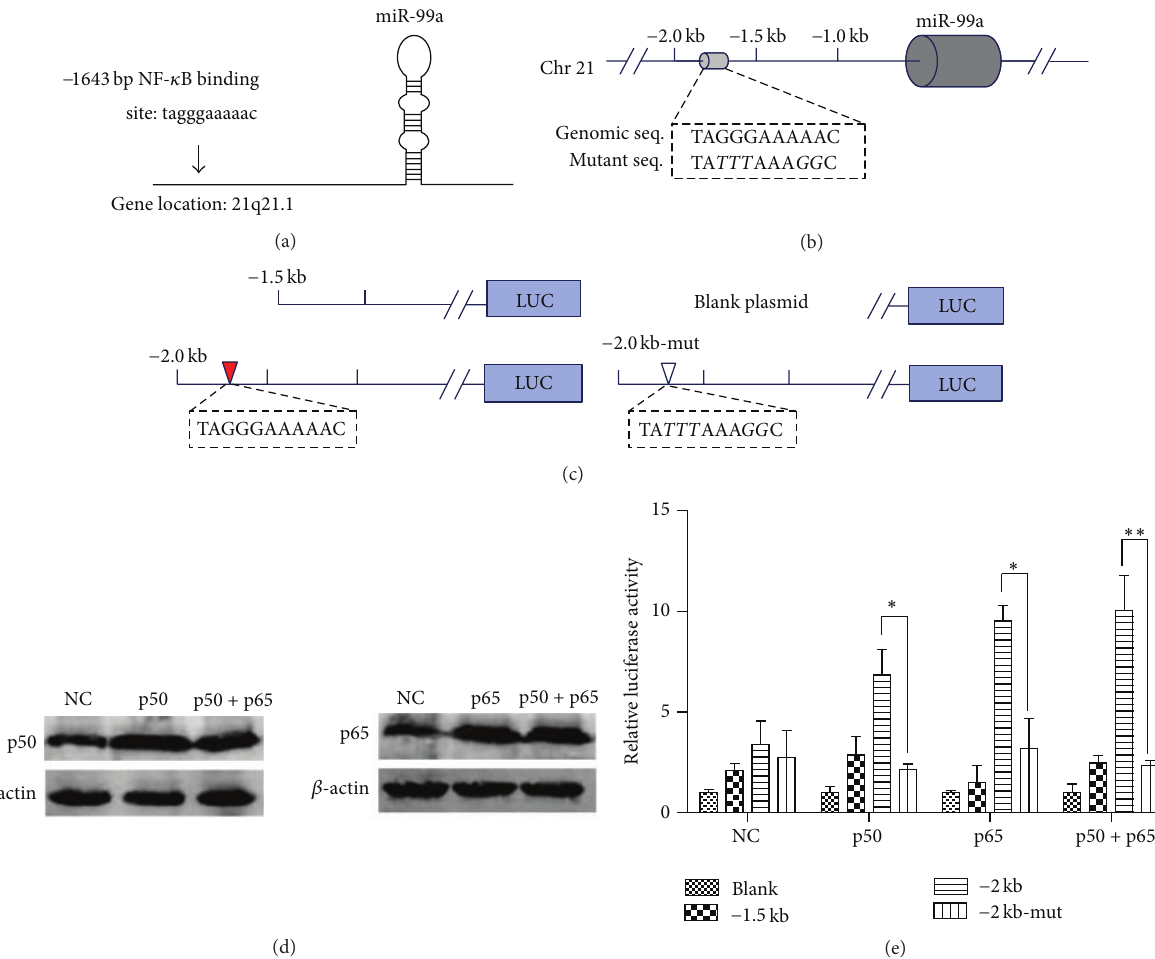
Figure 4: Dual luciferase reporter analysis of the regulate effects of NF- 𝜅 B on miR-99a promoter plasmids. (a) The predicted NF- 𝜅 B binding sites in miR-99a promoter analyzed by PROMO software. ((b), (c)) Portions of the upstream region of miR-99a cloned to create − 1.5 kb, − 2.0 kb, and − 2.0 kb-Mut plasmids. (d) The increased p65 or p50 protein levels in HEK293 cells after being transfected with 150 ng of NF- 𝜅 B subunit ORF cDNA Clones (p50, p65, or p50 + p65) in 24-well plates for 48 hours. (e) Relative luciferase activity of different promoter reporter plasmids after NF- 𝜅 B overexpression. The values (mean ± SD from three independent experiments) are relative to NC-Blank, which was set as 1. ∗ 𝑃 < 0.05 ; ∗∗ 𝑃 < 0.01